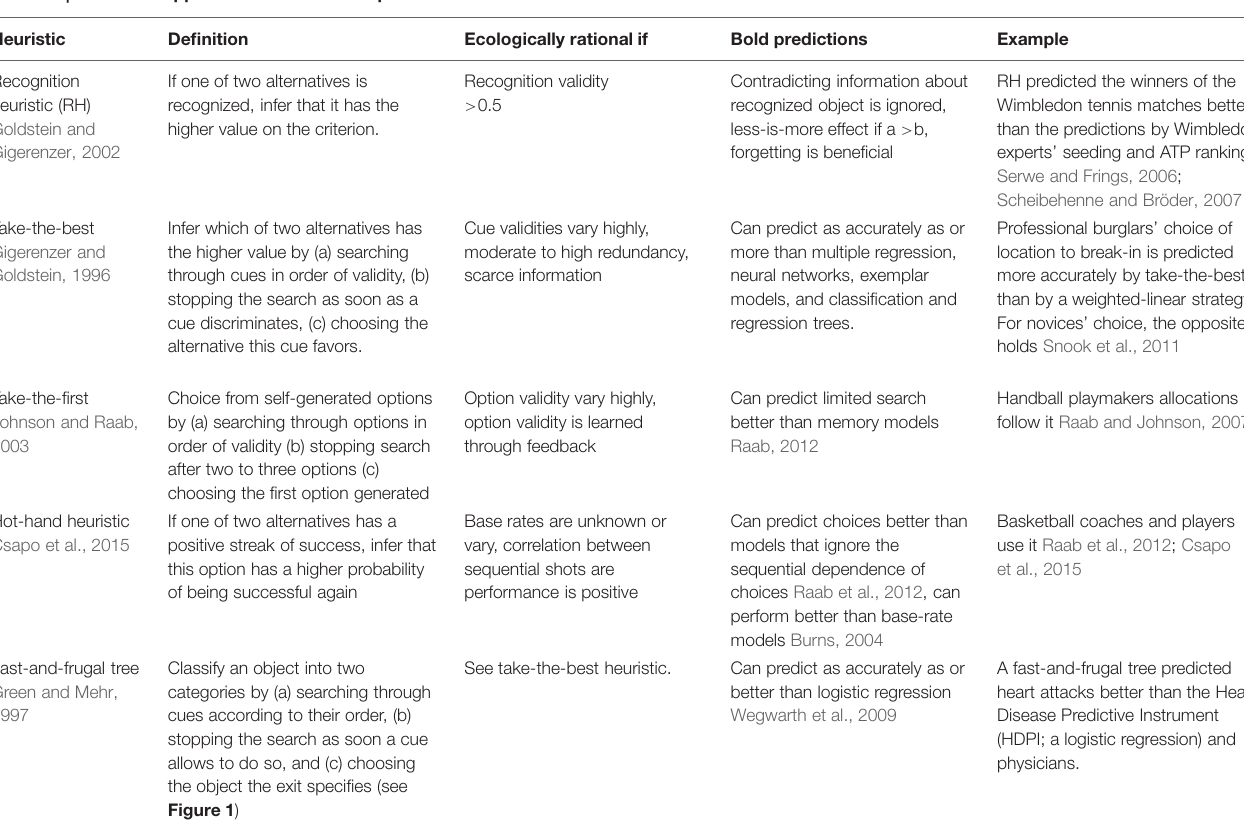
TABLE 1 | Heuristics applied to medicine and